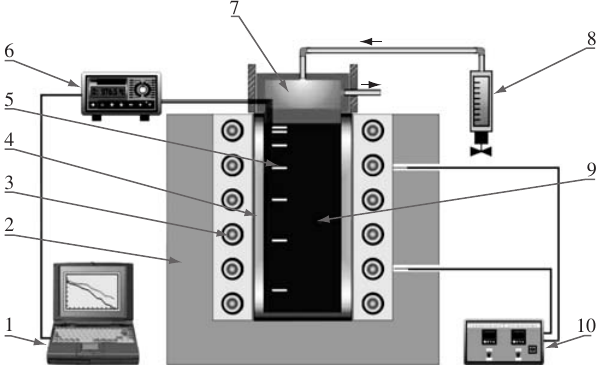
Figure 1. Schematic representation of the experimental setup: 1) data storage computer; 2) insulating ceramic shielding; 3) electric heaters; 4) stainless steel mold; 5) thermocouples; 6) data logger; 7) water-cooled chamber; 8) rotam- eter; 9) casting; and 10) temperature